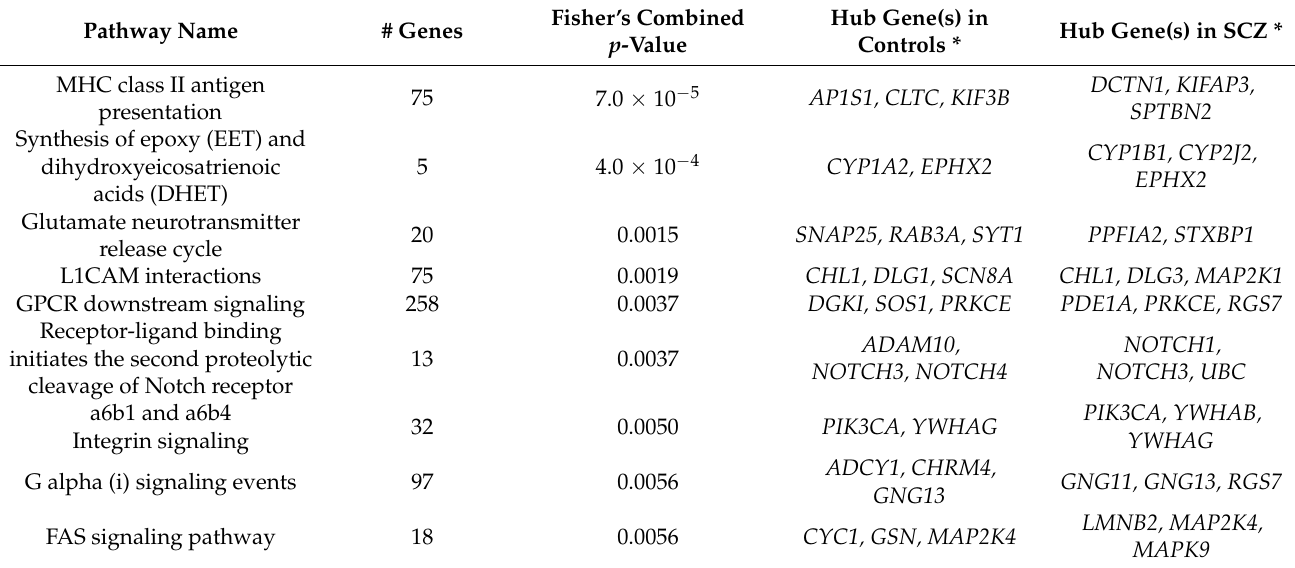
Table 3. Biological pathways showing significant internal correlation structure rewiring in three of the five exam- ined